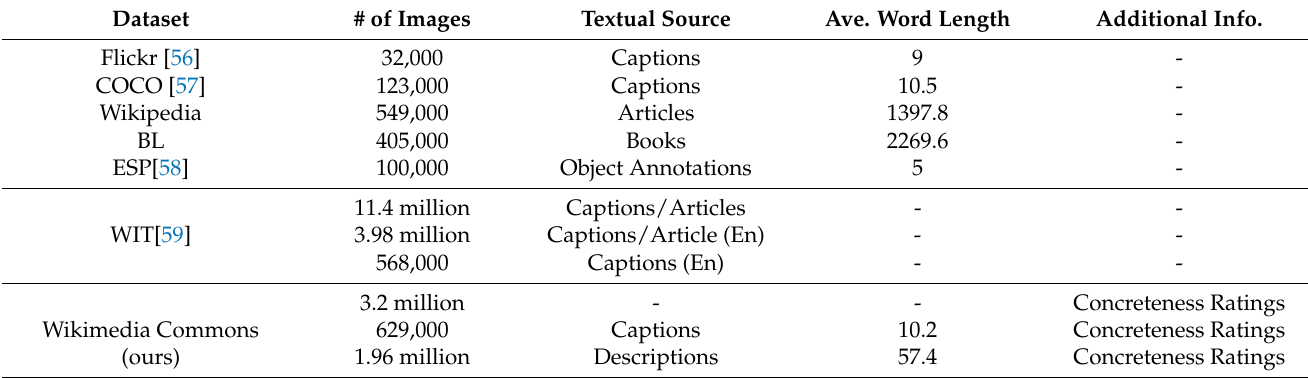
Table 2. Comparison of Wikimedia Commons to other multi-modal